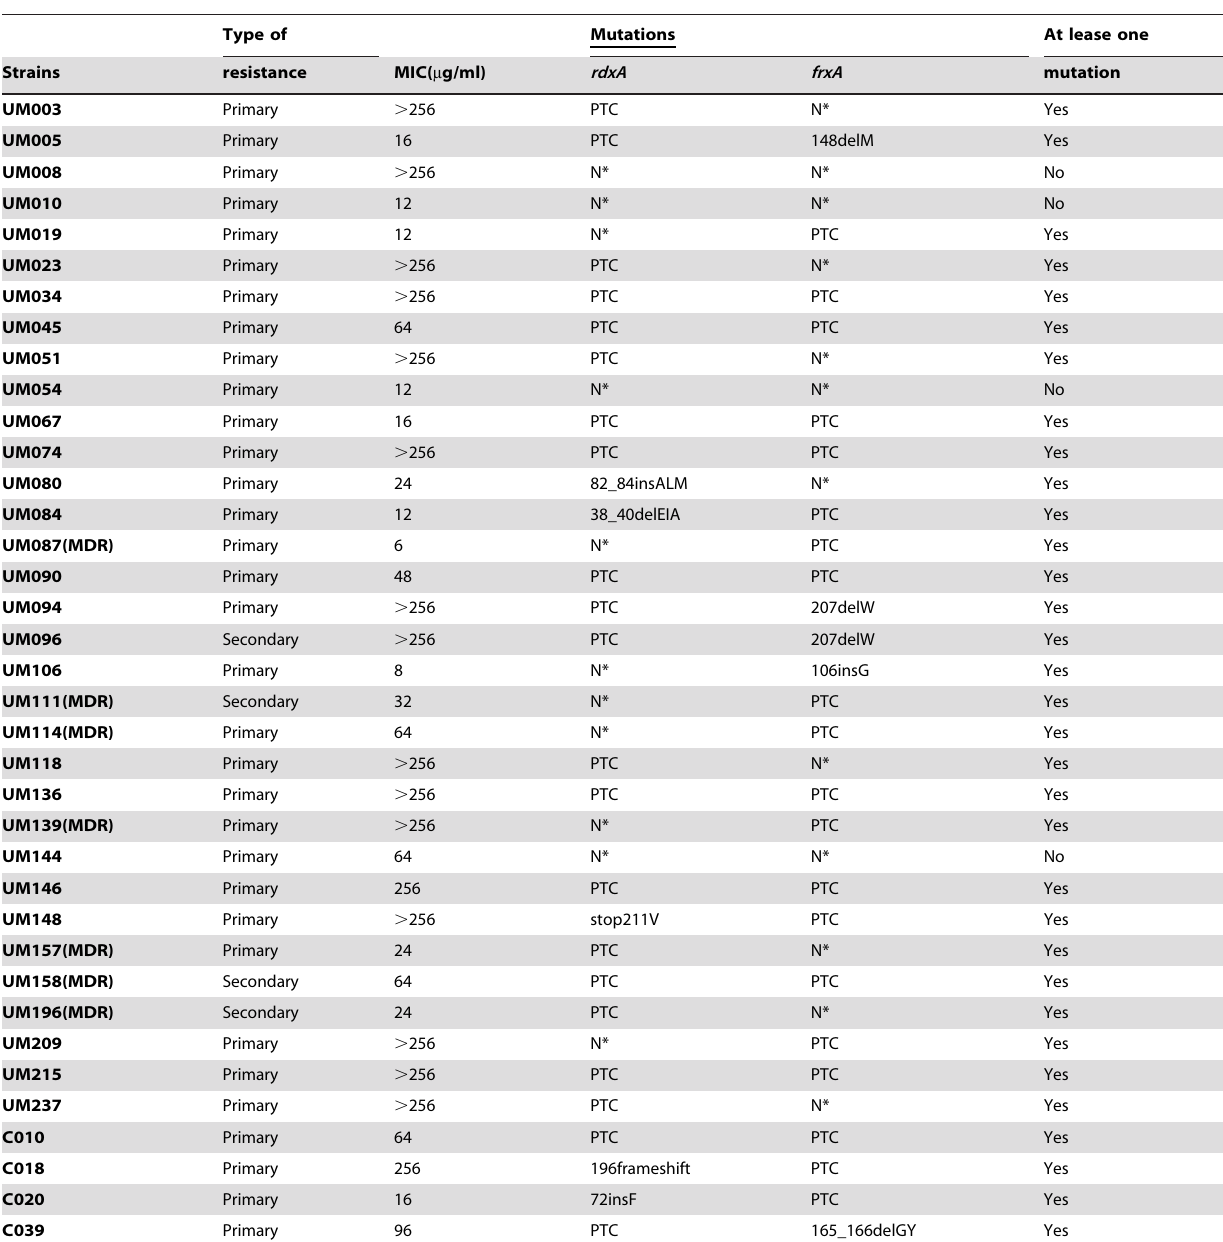
Table 4. MIC of metronidazole and rdxA and frxA mutations.